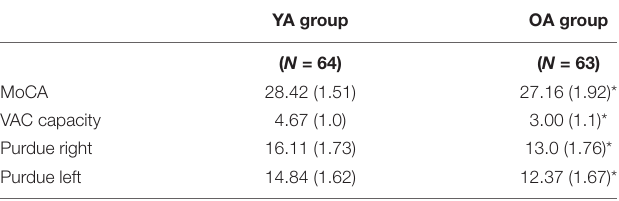
TABLE 1 | Mean (SD) age group scores for the MoCA, Purdue Pegboard, and spatial working memory capacity (visual array capacity). YA group